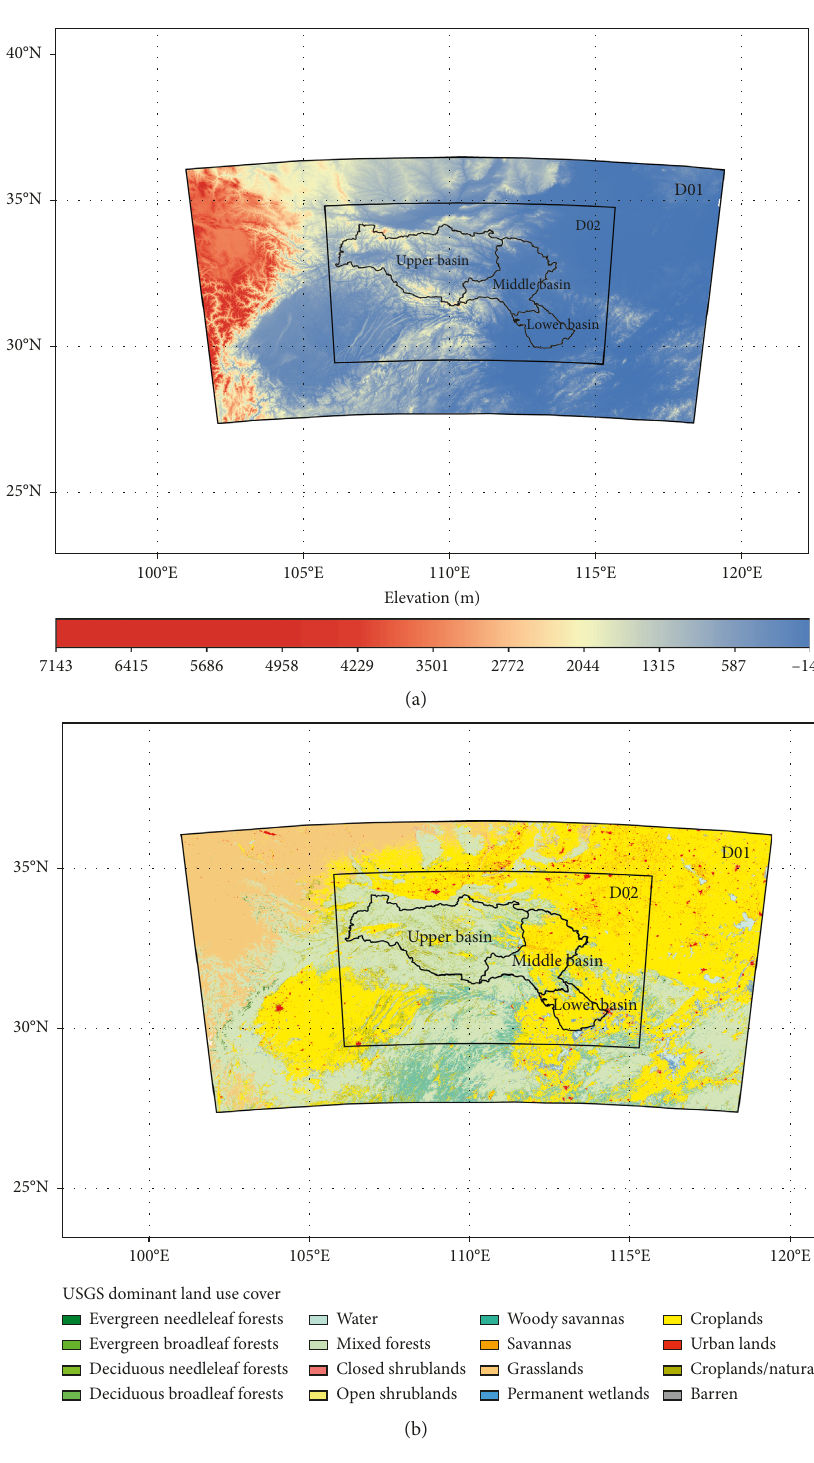
Figure 1: (a) WRF model domain configuration and (b) land use cover type derived from the U.S. Geological Survey (USGS) Long Term